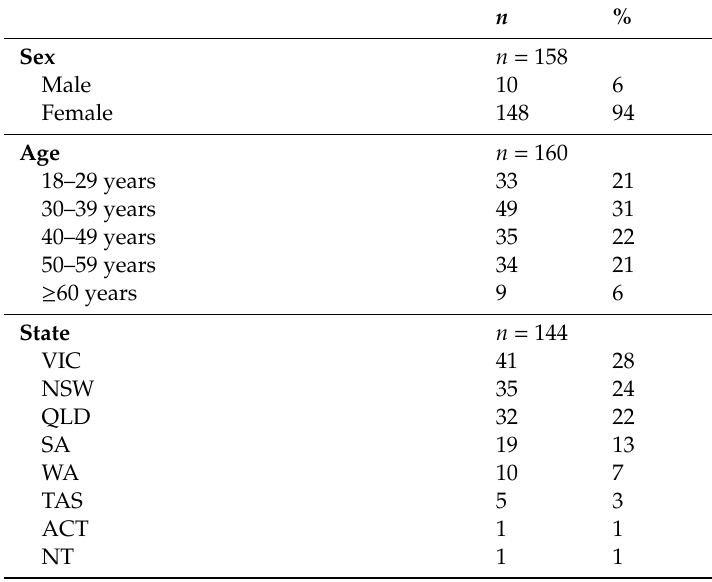
Table 1. Sociodemographics of allied health